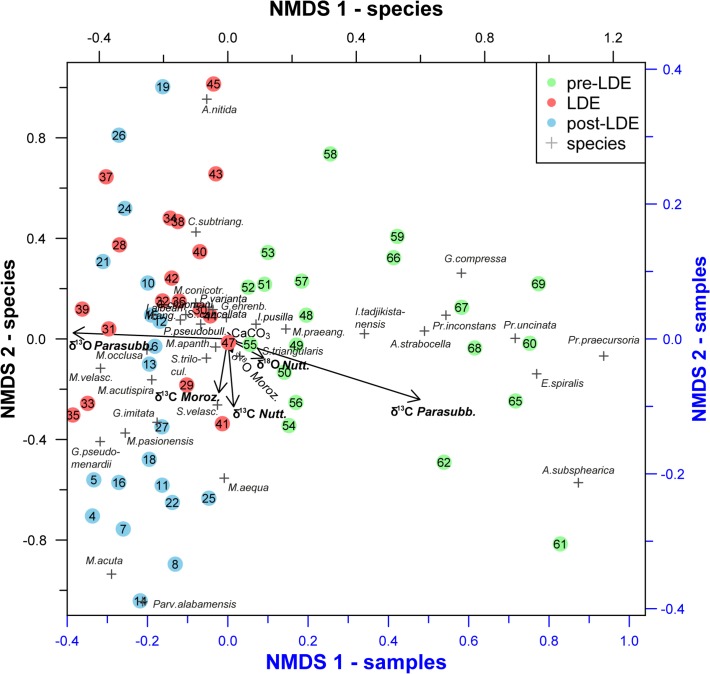
Non-Metric multidimensional Scaling.Results of multivariate analysis (non-metric multidimensional scaling, NMDS, stress = 0.17) showing differences of faunal communities (species-level) between the event stages. Most obvious is a strict division between pre-LDE (green, >234.45 rmcd, numbers 48–59) and post-LDE fauna (blue, <233.75 rmcd, numbers 1–27), whereas the event fauna (red, numbers 28–47) is positioned between the previous two phases, in a mixed position within post-event samples. Numbers refer to samples numerated from top to bottom (cf. S1 Table). From the fitted environmental vectors, the δ13C and δ18O of subsurface dwelling Parasubbotinids are related to the major NMDS axis controlling the distribution. Only the vectors of δ13C and δ18O of the parasubbotinids are significant at the 95% level.